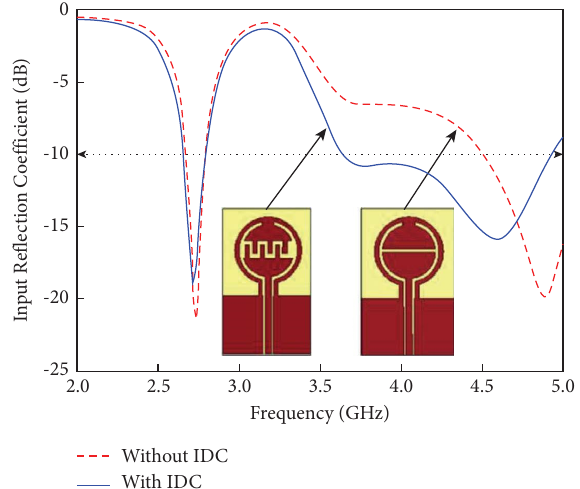
Figure 6: Input refection coefcient of proposed dual-band MTM with and without